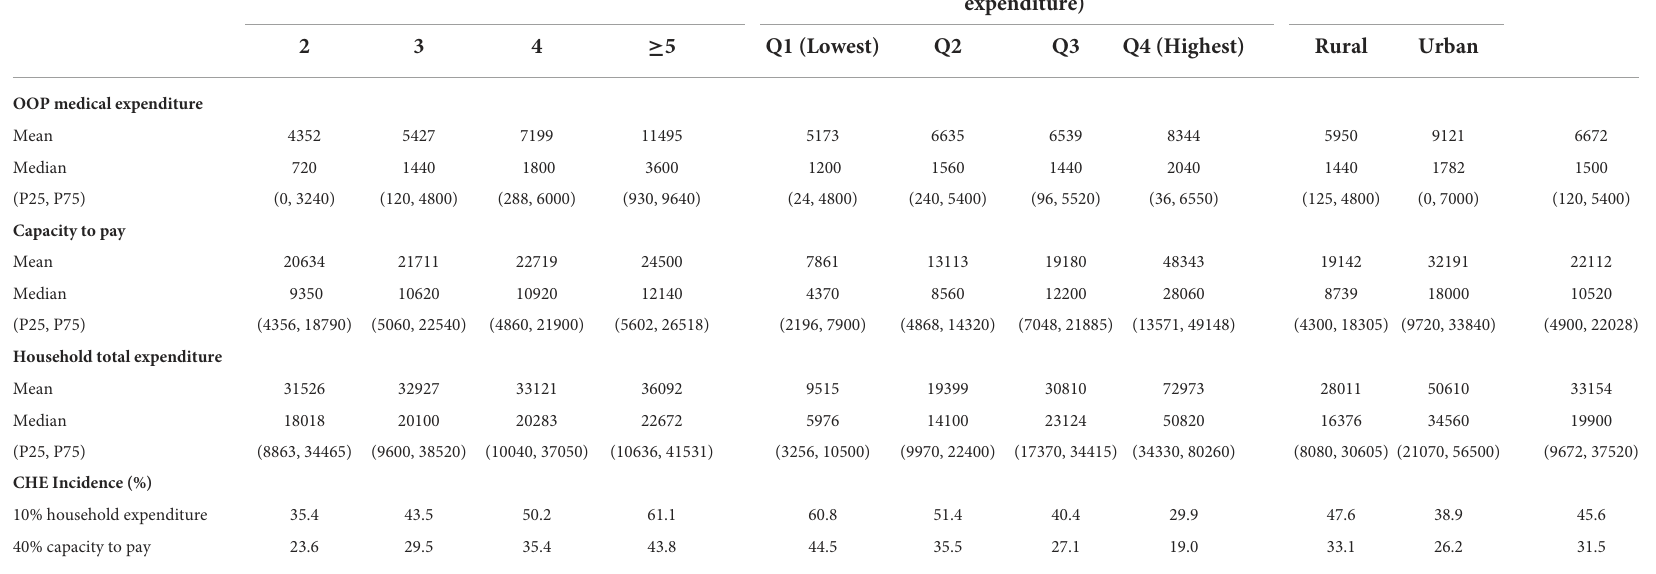
TABLE 2 Household burden of out–of–pocket (OOP) payment for medical expenditure and catastrophic health expenditure (CHE) of study participants ( n = 3511). Indicator Number of chronic conditions reported by